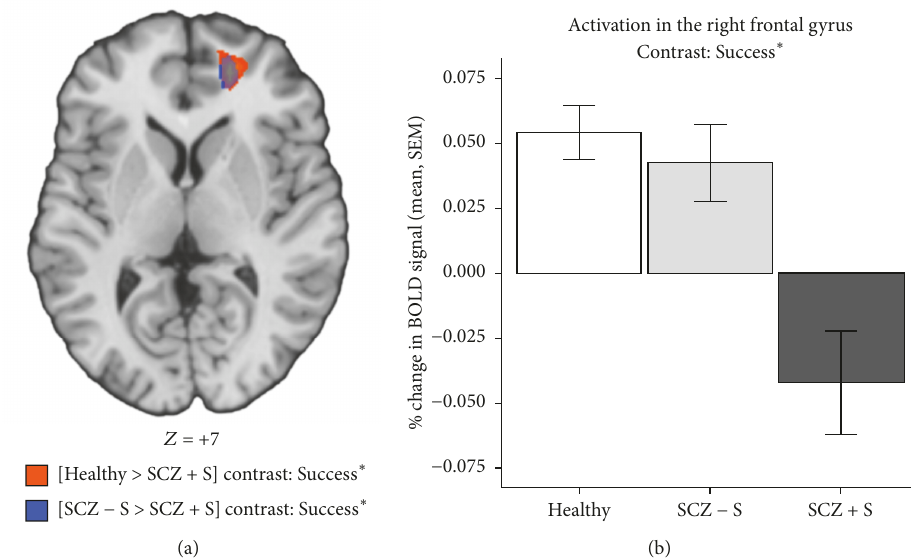
Figure 1: Group differences in BOLD responses of the right frontal gyrus during the success event. BOLD = blood oxygen level dependent; SCZ + S = schizophrenia with lifetime suicidal attempt; SCZ − S = schizophrenia without violent behavior or suicidal attempt; SEM = standard error of the mean; ∗ parametrically